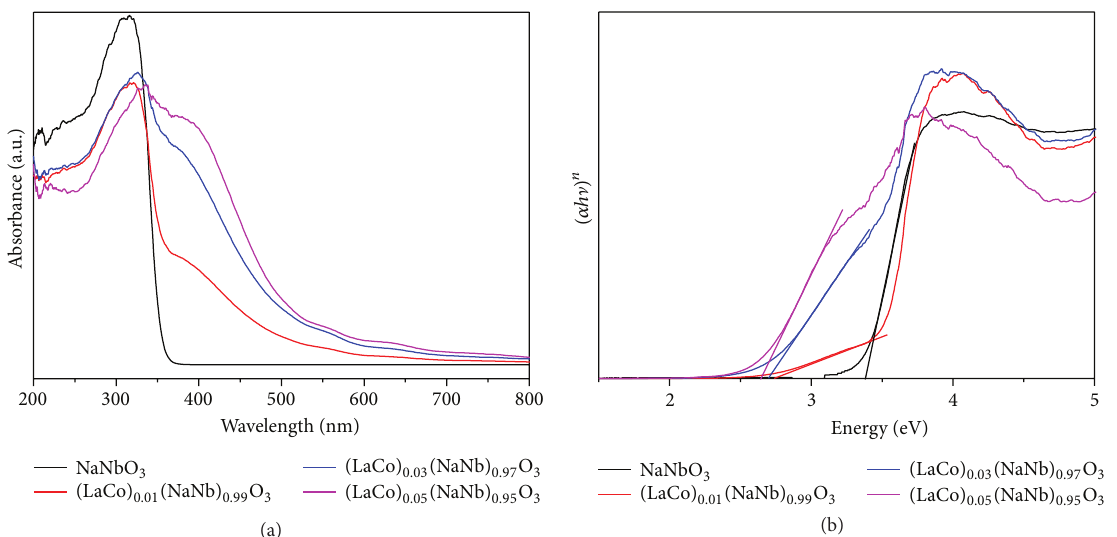
Figure 3: (a) UV-visible absorption spectra of the as-prepared NaNbO 3 and La, Co codoped NaNbO 3 . (b) The corresponding (𝛼ℎ ] ) 𝑛 ∼ ℎ ] curves of the as-prepared NaNbO 3 and La, Co codoped NaNbO 3 .